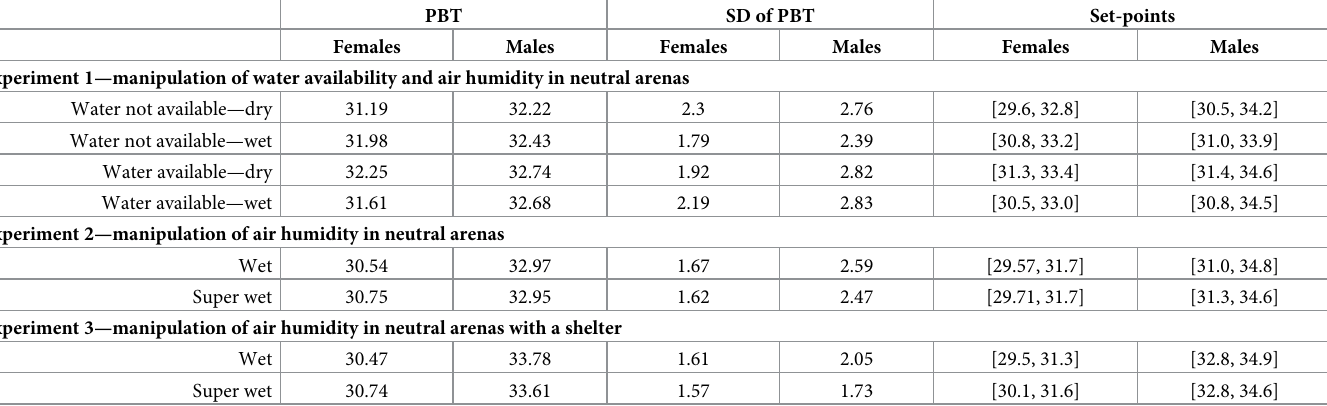
Table 1. Descriptive statistics for thermal preferences including preferred body temperatures (PBT), standard deviation around the mean (an index of thermal pre- cision), and set-points (50% quantiles, included for meta-analyses) in males and females from each